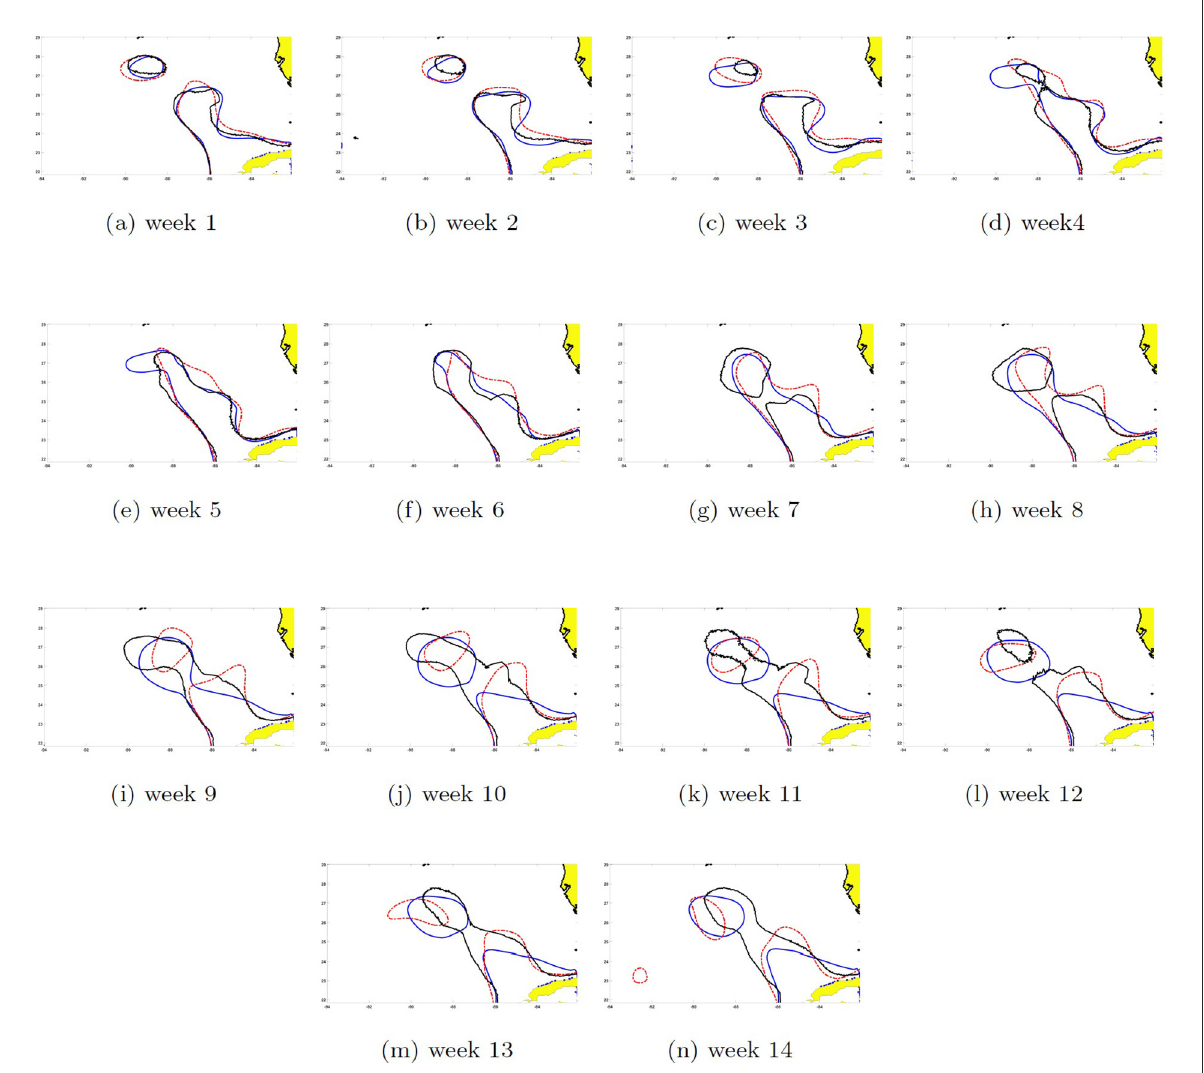
FIGURE14 Seas surface height contour (0.45 m) 14-week prediction of eddy Cameron started the third week of May 2008 for the DAC (black solid line) and the WELL (blue solid line) models. The solid red line shows the HYCOM SSH. Week 1 shows the prediction for the first week after the start date. (a–n) Week